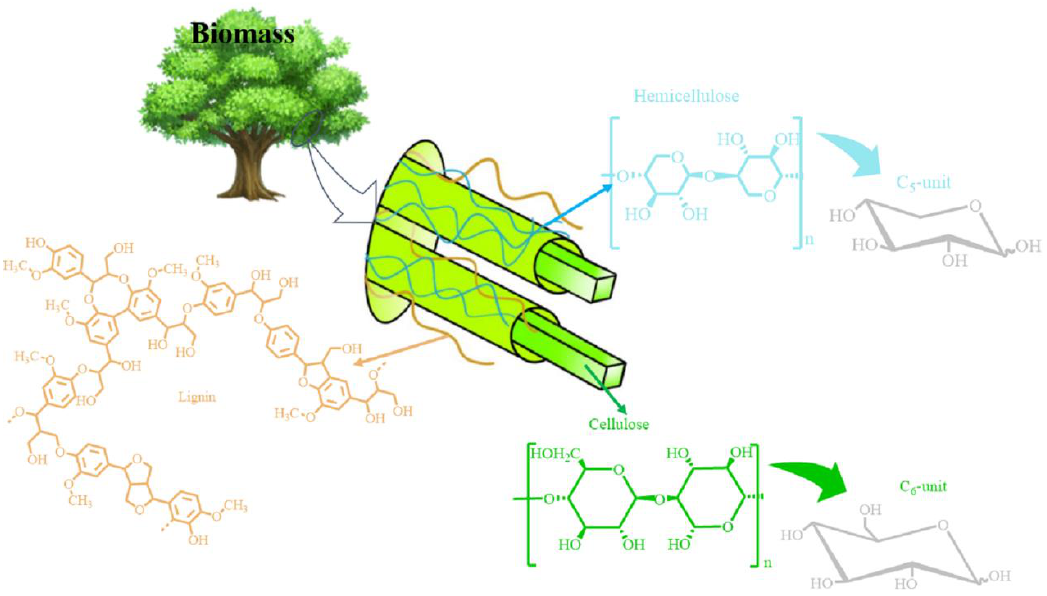
Figure 2. The chemical structure of lignocellulosic biomass components. Table 1. The different contents of the three main components for common biomass. Type of Biomass Cellulose/( wt .%) lose/( wt .%)